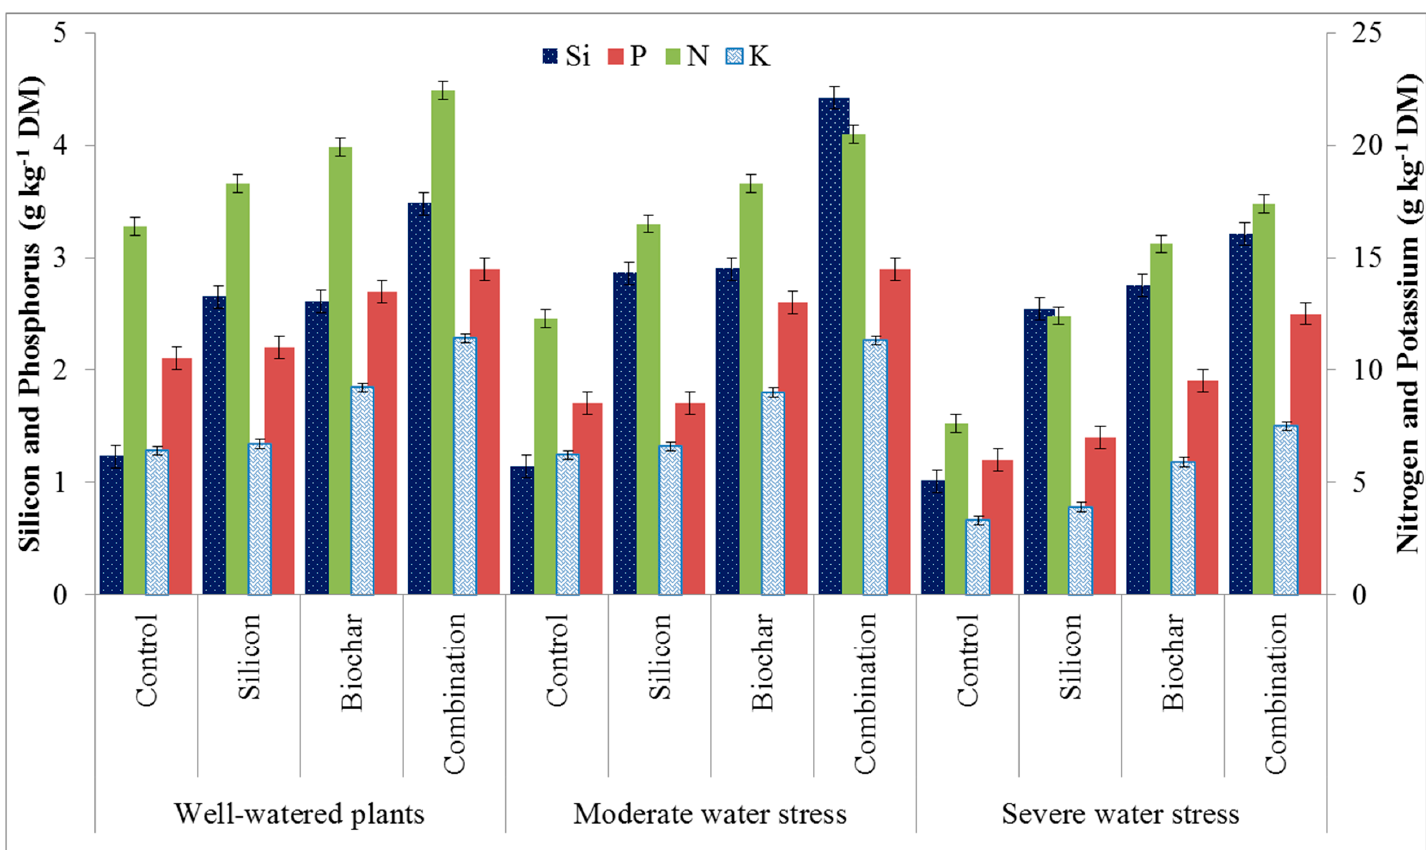
Figure 4. Effect of biochar and Silicon and their combination on Silicon (Si), Phosphorus (P), Nitrogen (N) and Potassium (K) content of sunflower biomass under water deficit stress treatments. Bars = Standard error of means (S.E.M). Table 5. Interaction effects of soil and foliar amendments and water deficit stress treatments on oil traits and fatty acids of sunflower during two growing seasons 2016 and 2017.